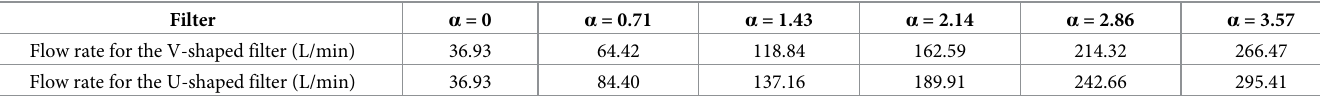
Table 2. Flow rate of filters under a filtration velocity of 4 cm/s. Filter α = 0 α = 0.71 α = 1.43 α = 2.14 α = 2.86 α =